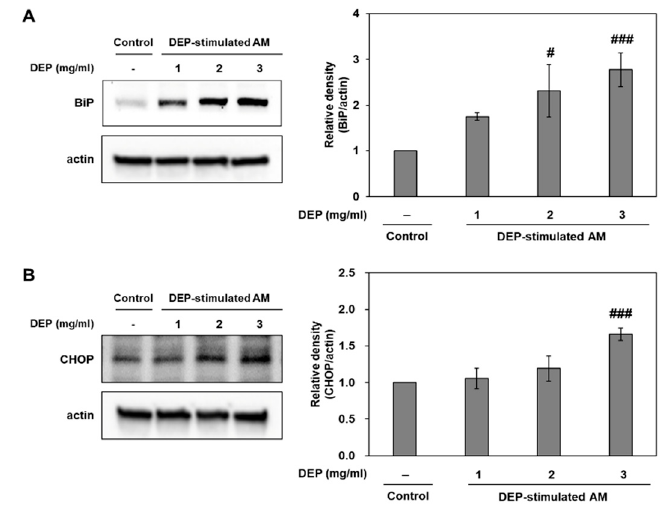
Figure 5. Expression levels of the ER stress markers BiP and CHOP in DEP-stimulated AM. Representative Western blots and relative densities of ( A ) BiP and ( B ) CHOP in DEP-stimulated AM. AM were stimulated with DEP 1, 2, or 3 mg mL − 1 . Western blotting was performed 3 h after DEP stimulation. Data are means ± SD ( n = 3 per group). # p < 0.05 or ### p < 0.001 vs. control.